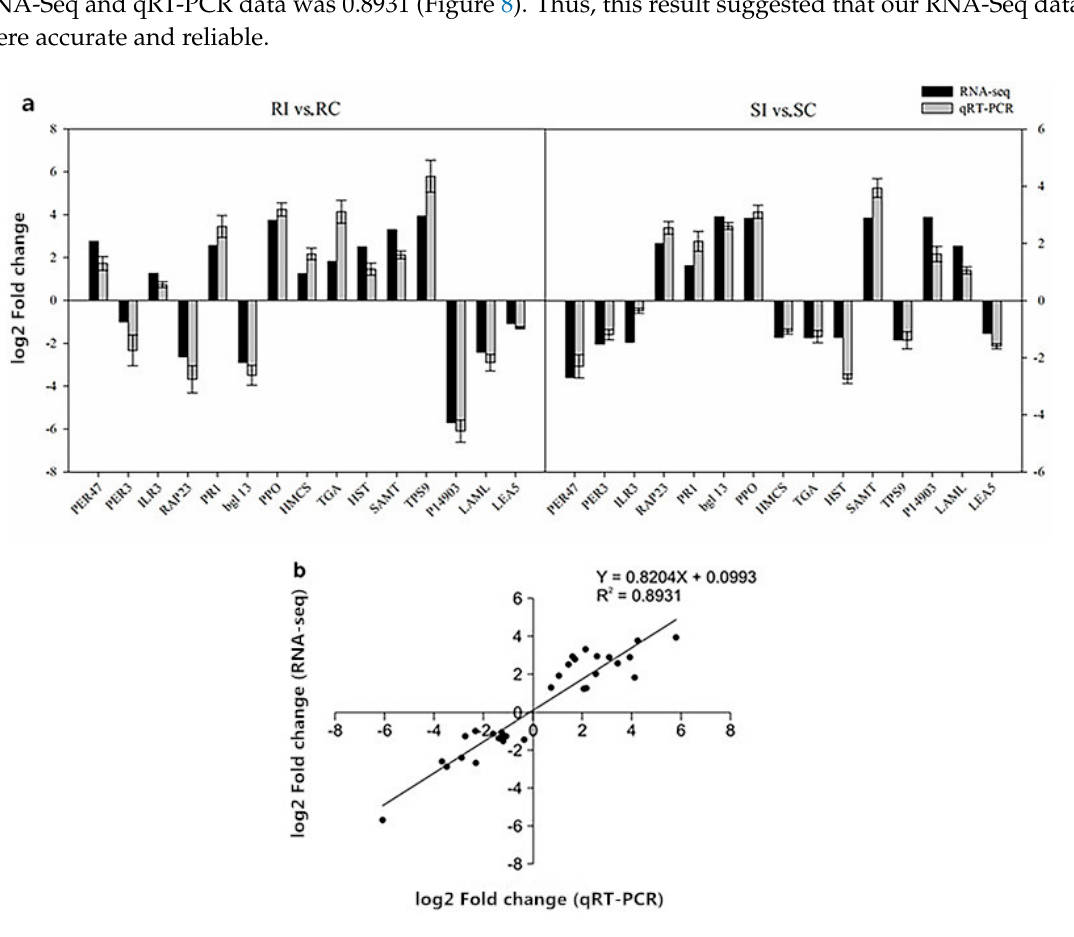
Figure 8. ( a ) Quantitative real-time polymerase chain reaction (qRT-PCR) validation of selected differentially expressed genes. ( b ) The RNA-Seq data (X-axis) were plotted against the qRT-PCR data (Y-axis). The function of the regression line and the R 2 value are shown.